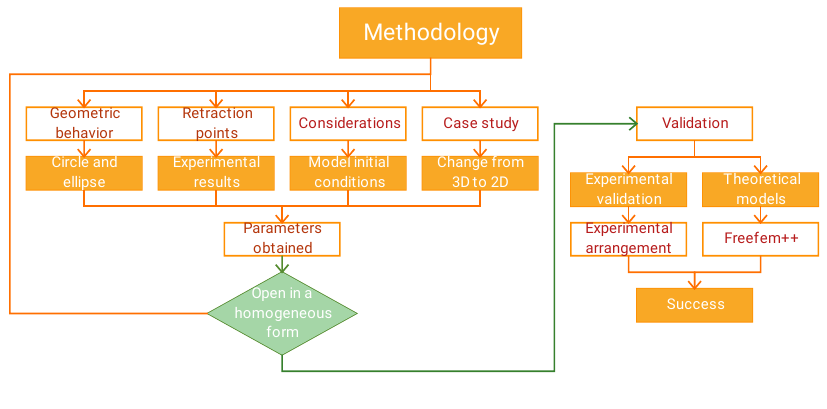
Figure 2. Methodology defined to design specifications for an robotic retractor